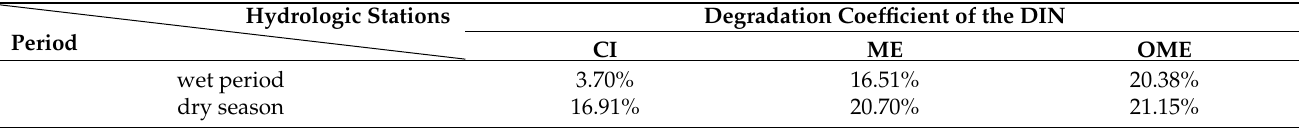
Table 2. Calibration error in the DIN concentration at the monitoring points in the coastal waters of the Minjiang Estuary.